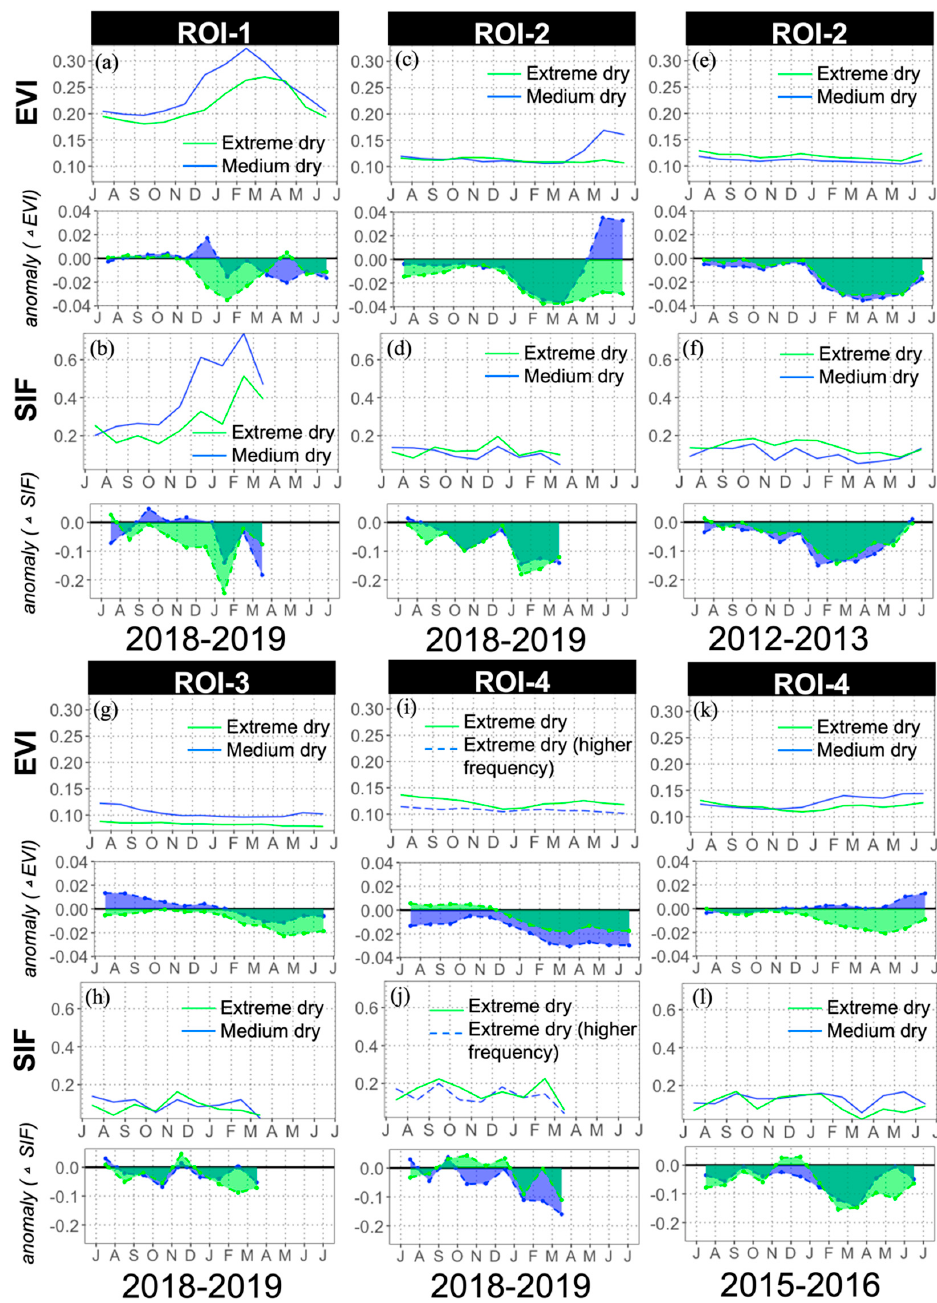
Figure 6. Region-wide seasonal cycles and anomalies of ( a , c , g , i ) EVI and ( b , d , h , j ) SIF within four pairs of ROIs in 2018–2019. Seasonal profiles of SIF and EVI within ( e , f ) ROI–2 in 2012–2013 and ( k , l ) ROI–4 in 2015–2016. Bottom panels of each figure refer to the anomalies of SIF or EVI relative to climatology (2007–2018).